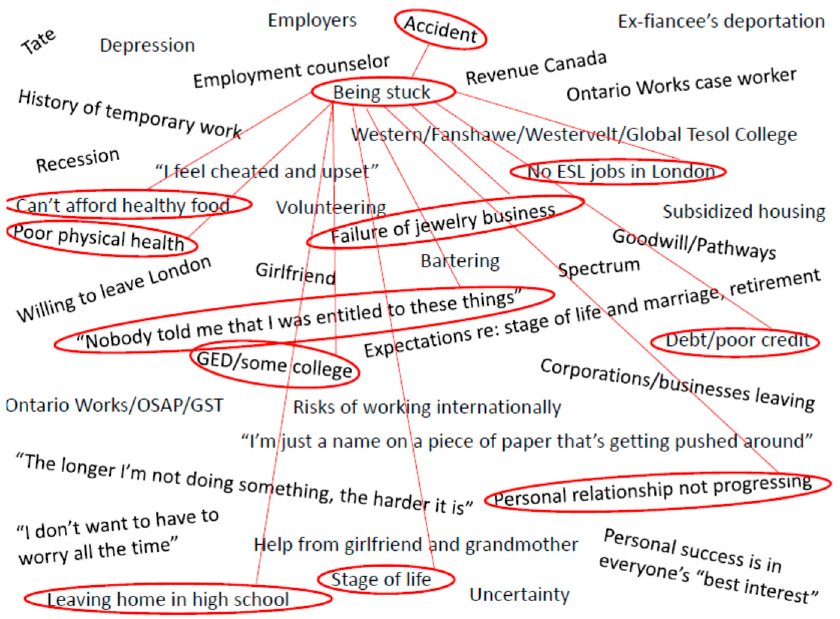
Figure 3. Relational situational map—Tate.